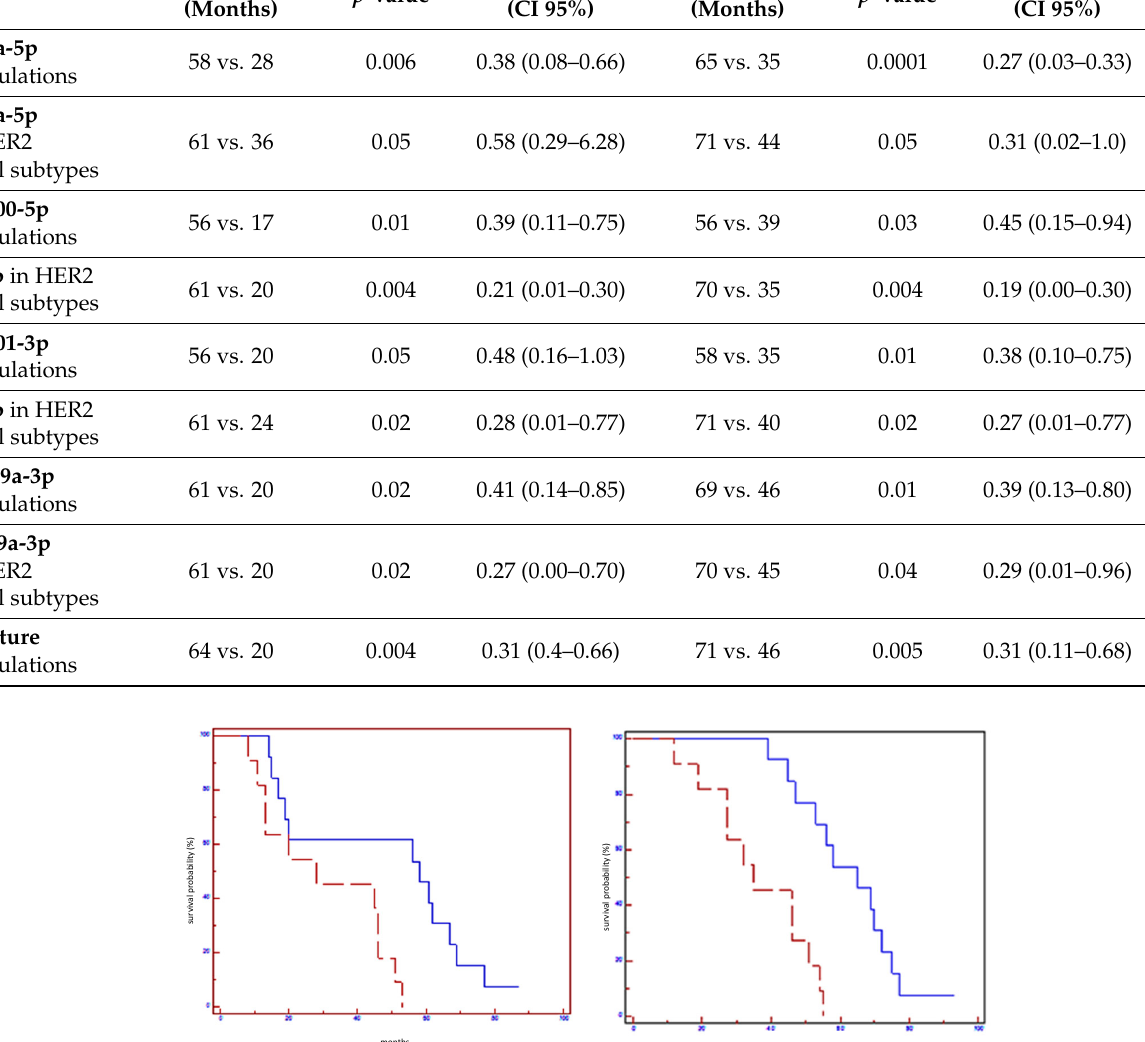
Figure 1. Prognostic impact of Let7a ‐ 5p on EFS (on the left) and on OS (on the right) in all population: blue line refers to patients with overexpression of Let7a; red line refers to patients without overexpression of Let7a ‐ 5p.